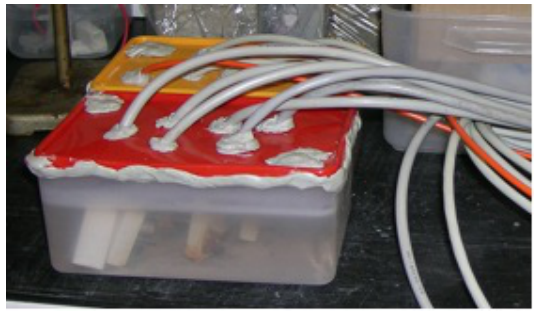
Figure 3. Photo of the PVC cell with the 12 sensors immersed in a thermostated